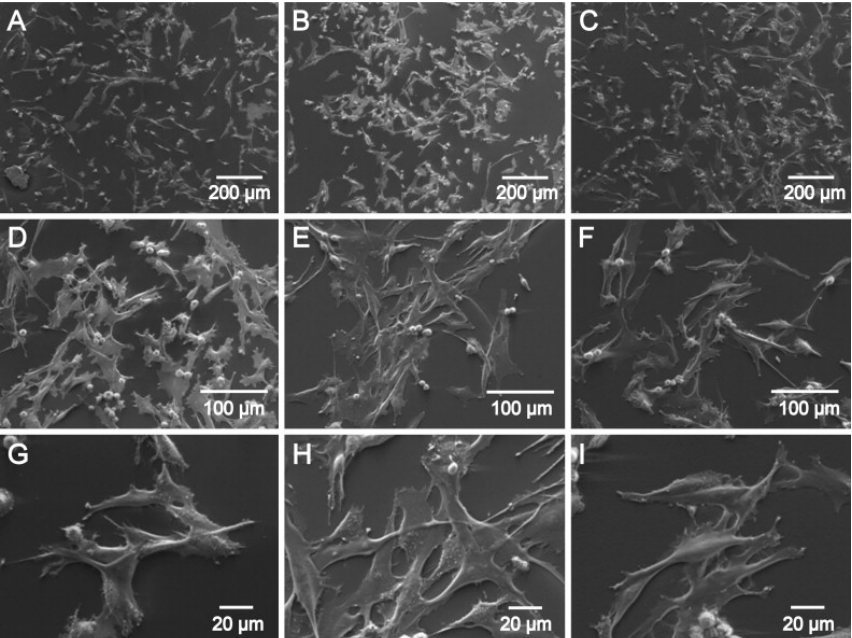
Figure 5. SEM micrographs (three different magnifications) showing the prevalence, morphology, and adherence of BHK-21 cells at 24 h after cultured on different polyimide surfaces: ( A , D , G ) conventional, non-photosensitive PI2525 cured at 200 °C; ( B , E , H ) photosensitive PI2771 cured at 200 °C; ( C , F , I ) photosensitive PI2771 cured at 350 °C. Adapted from [28], with permission from © 2010 Elsevier.